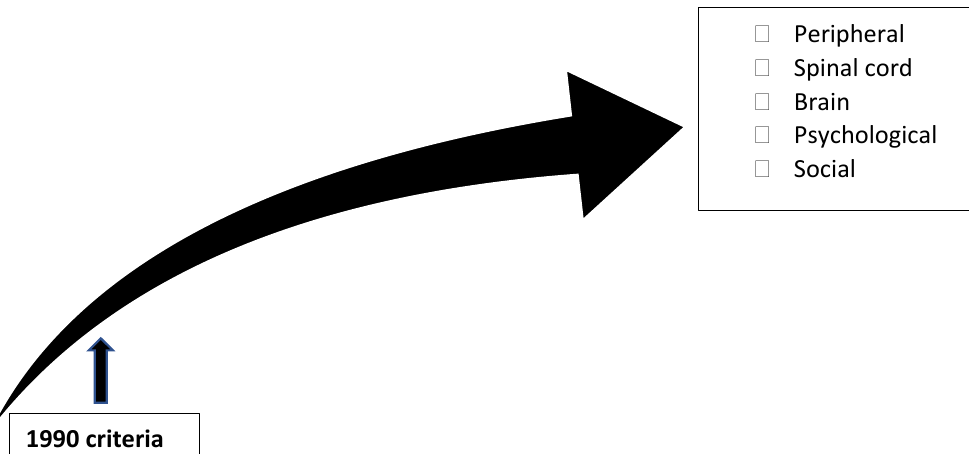
Figure 1. The 1990 ACR criteria accelerated and broadened the curve of knowledge of mechanisms contributing to fibromyalgia in many overlapping domains.